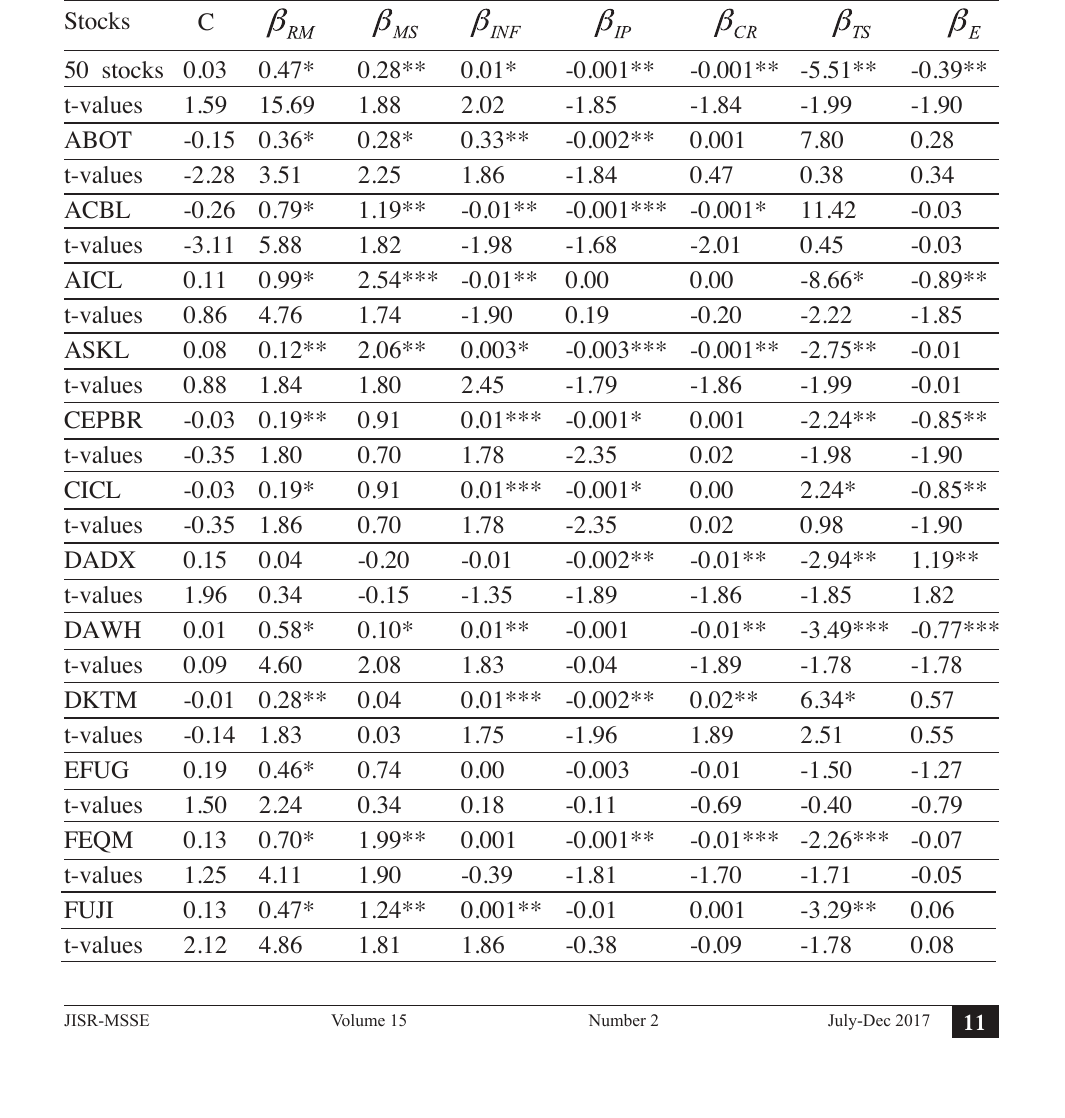
Proportionality Coefficients and Factor Sensitivities (Beta) of Individual Stocks and Overall